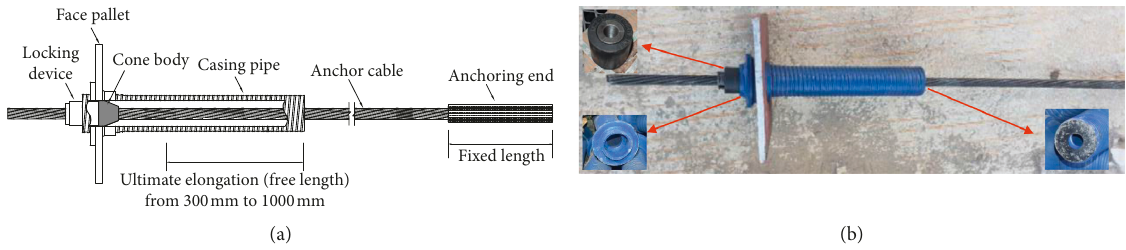
Figure 8: NPR constant resistance and large deformation anchor cable. (a) Composition of the NPR anchor cable. (b) Photos of the NPR anchor